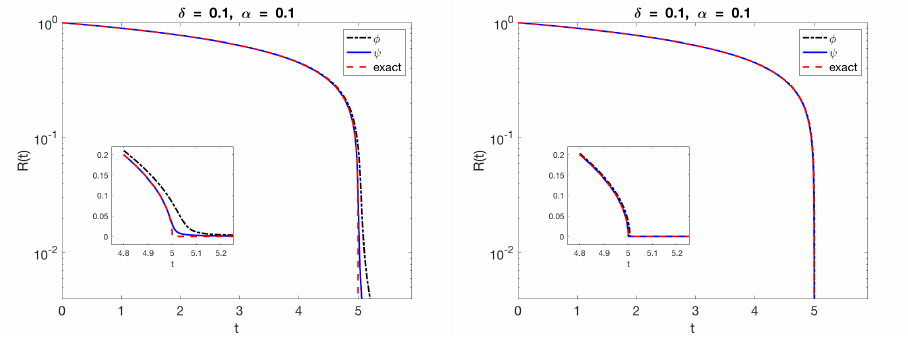
(black) and π ( r 2 + δ 2 ) 3